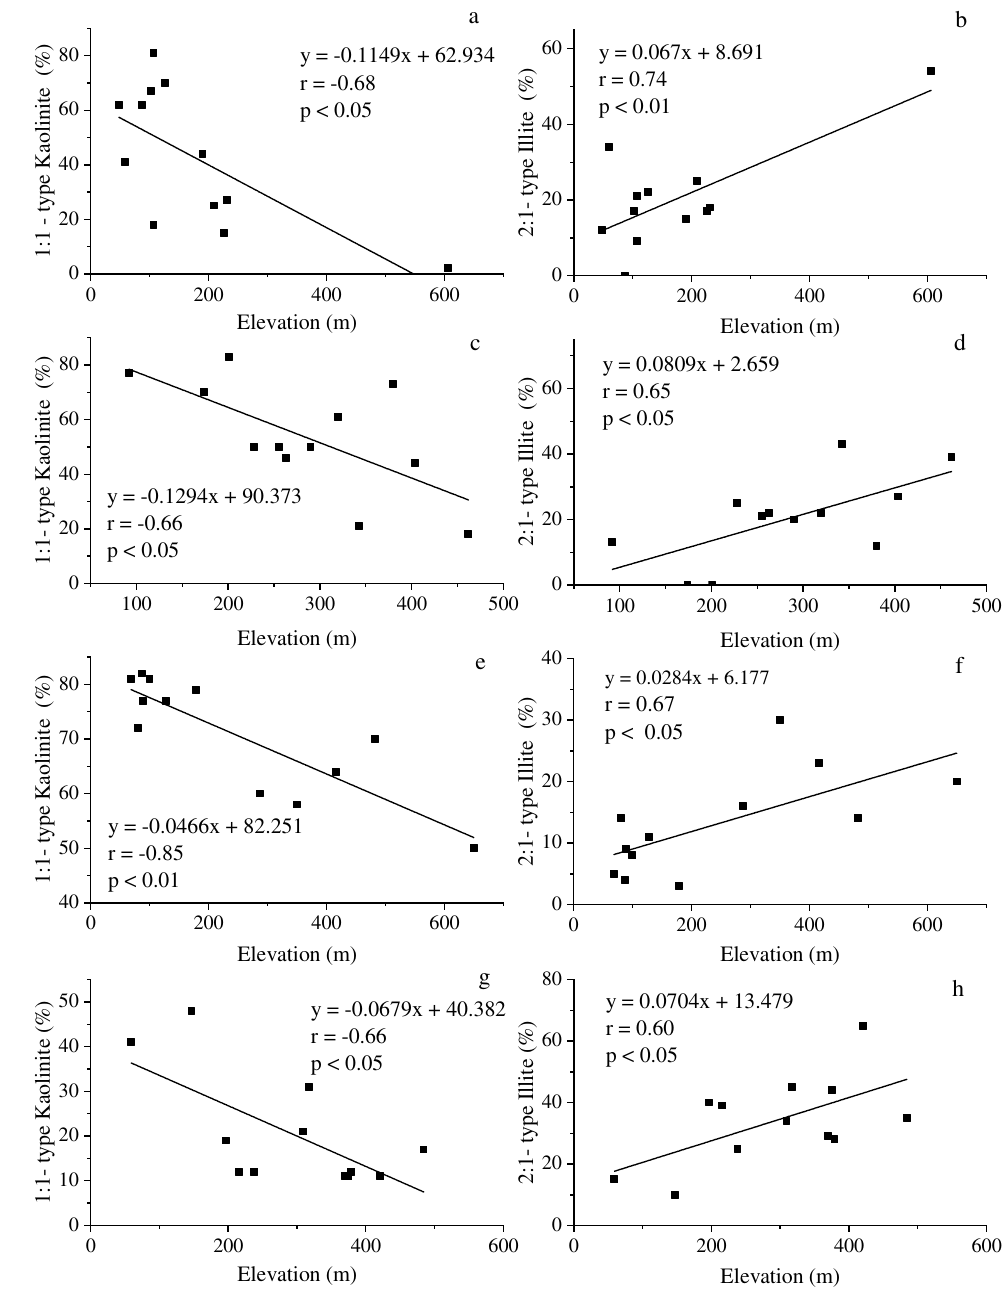
Figure 4. Relationships between relative content of clay minerals and elevation for the studied soils ( a , b : slate and shale; c , d : limestone; e , f : granite; g , h :